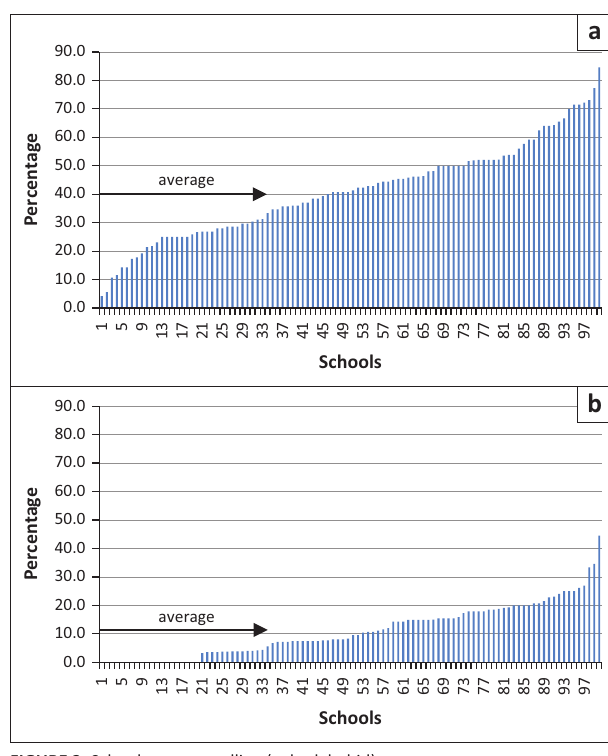
FIGURE 3: School correct spelling (a. bed, b. bid) averages.